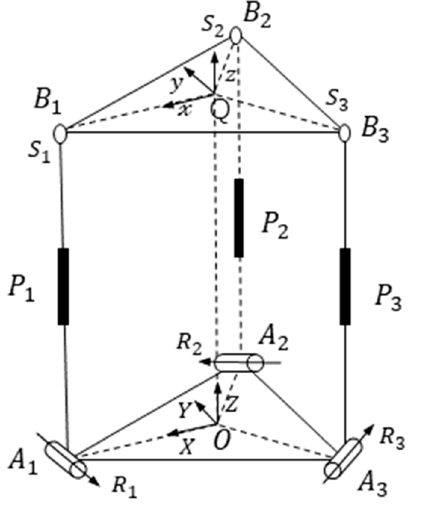
Figure 9. The 3-SPR kinematics model.